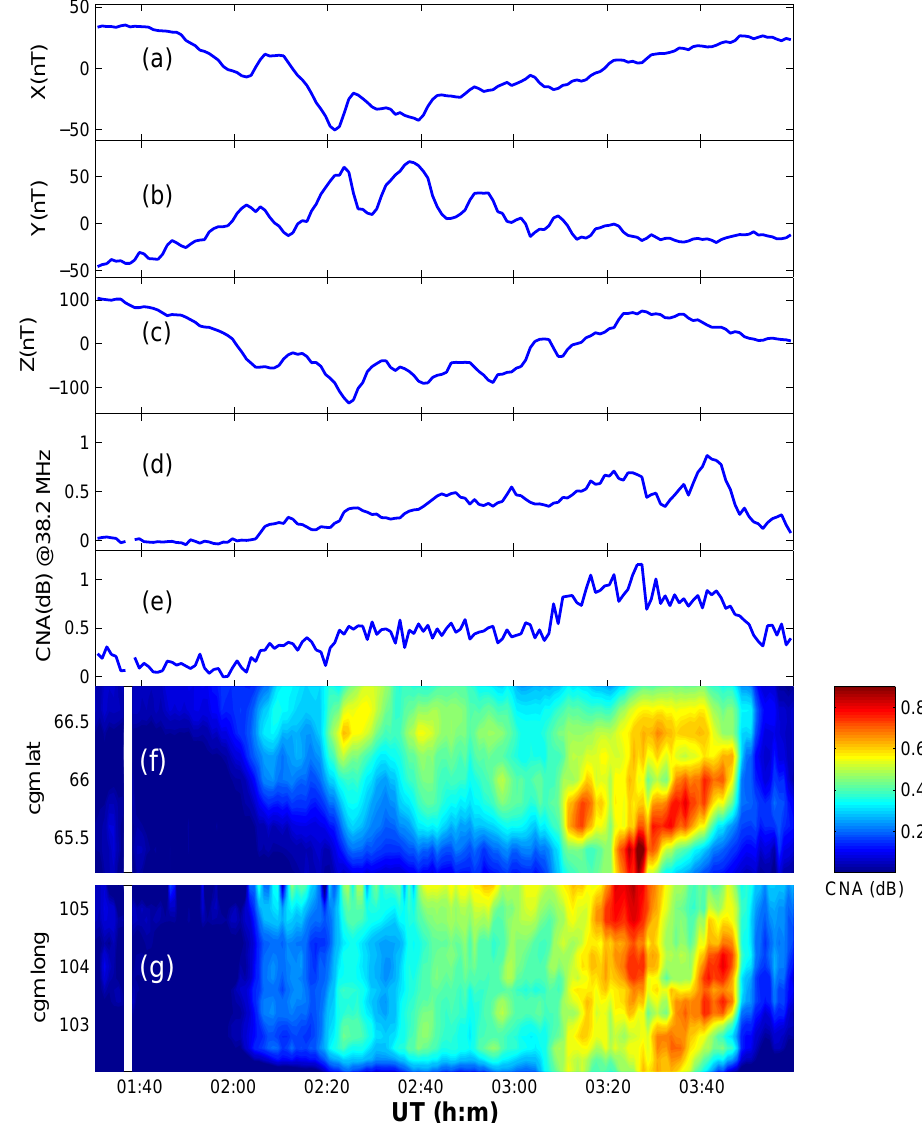
Fig. 2. Data from the magnetometer at Kilpisj¨arvi (KIL) (a–c) and corresponding riometer data from IRIS (d–g) showing signatures of the Ps6 pulsation on 11 May 1998. The central beam of IRIS (d) shows the pulsation whereas the co-located widebeam (e) does not. Panel (f) is a keogram of the latitudinal variation of CNA taken at the longitude of the Tromsø magnetometer where the pulsation is strongest. Panel (g) presents an east-west slice across the IRIS field of view where the eastward motion of the precipitation structures becomes